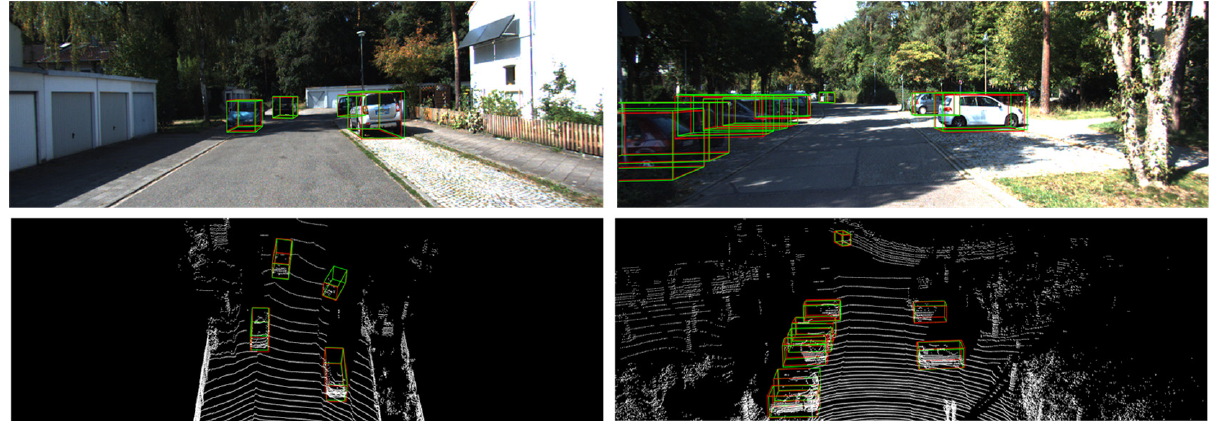
Figure 8. A visualization result of cars using the KITTI validation set. We present paired samples, where in each pair, row 1 is the 3D bounding boxes projected into the image for clearer visualization, while row 2 is the detection result of the LiDAR point cloud. We use red and green boxes to denote detections and ground truth boxes, respectively.